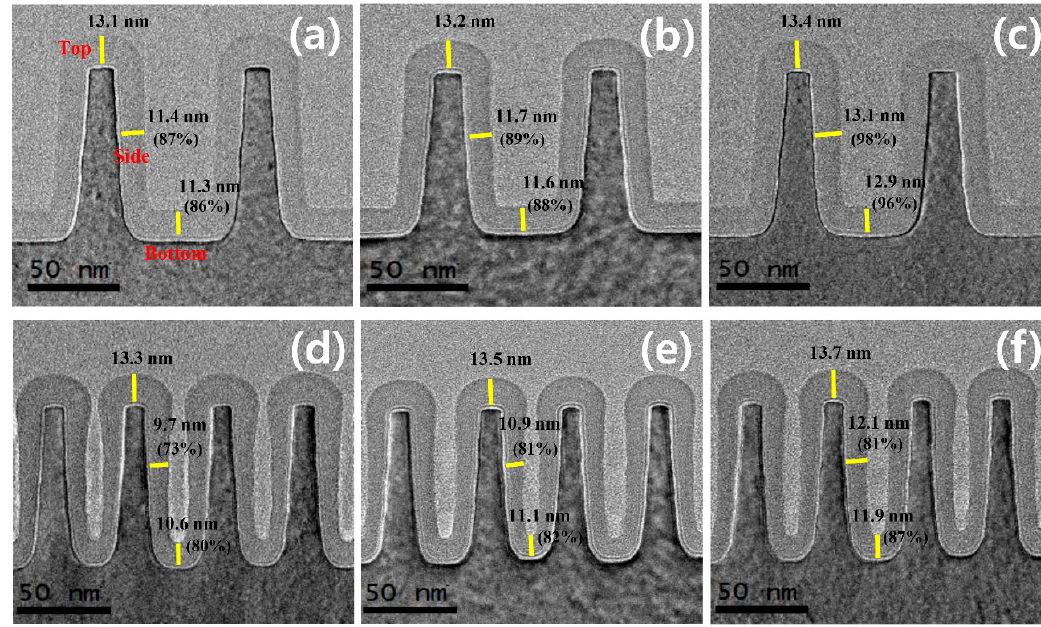
Table 1. Wet etch rate of the RPALD SiN x film as a function of deposition temperature. Temp. (°C)